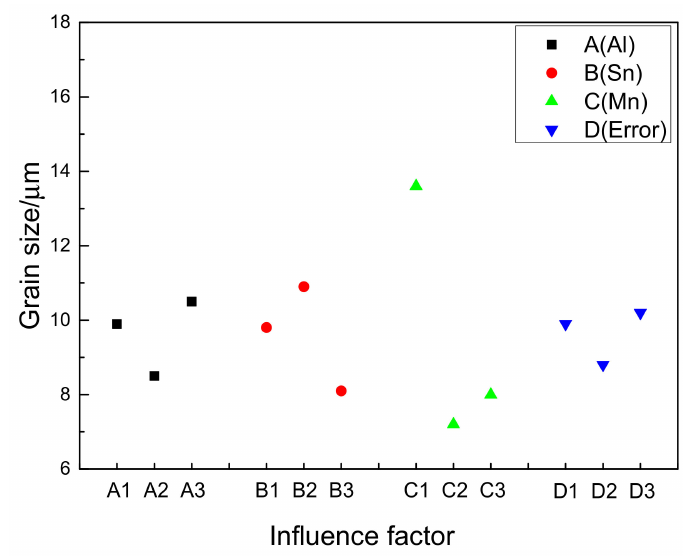
Figure 5. Factors and Index trends diagram of grain size for nine trial samples.